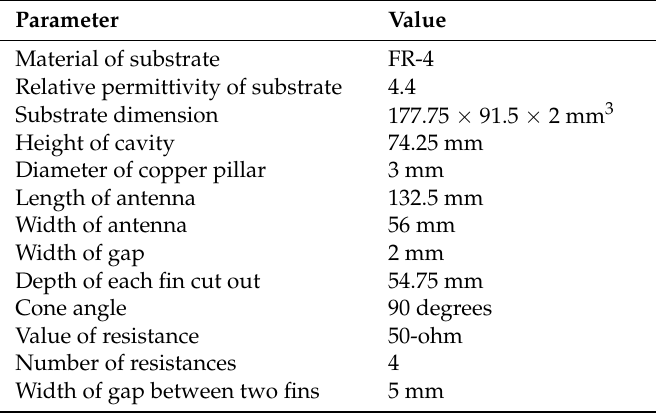
Figure 7. ( a ) This is the general view of modified antenna; the reflection cavity consists of a piece of copper sheet and four copper pillars; ( b ) This is the photo of antenna’s fin made by copper sheet. Table 3. Design Parameters of the MOA.